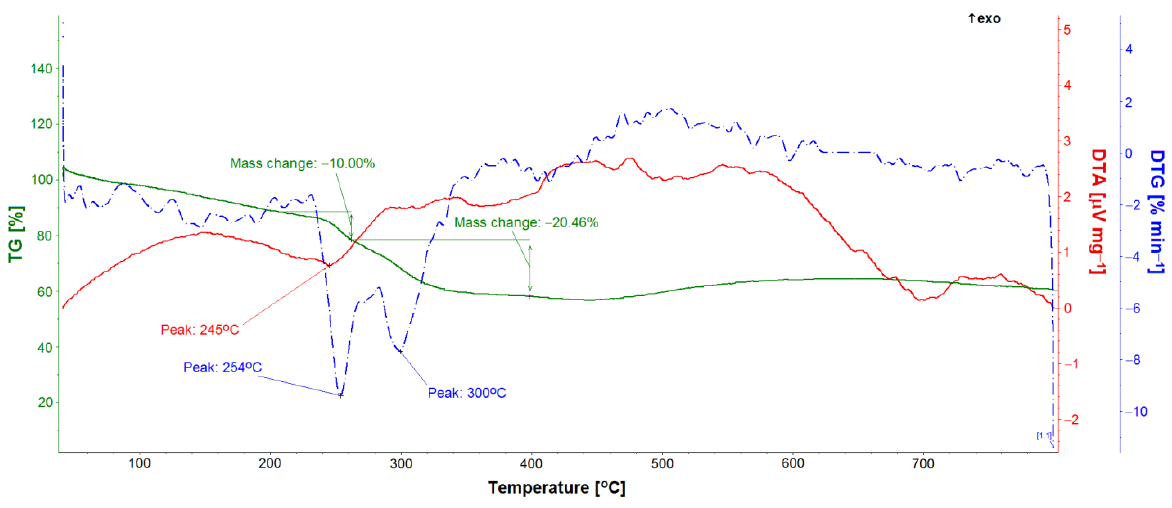
Figure 12. TG, DTA, and DTG curves and evolved gas analysis of gentamicin sulfate sample.